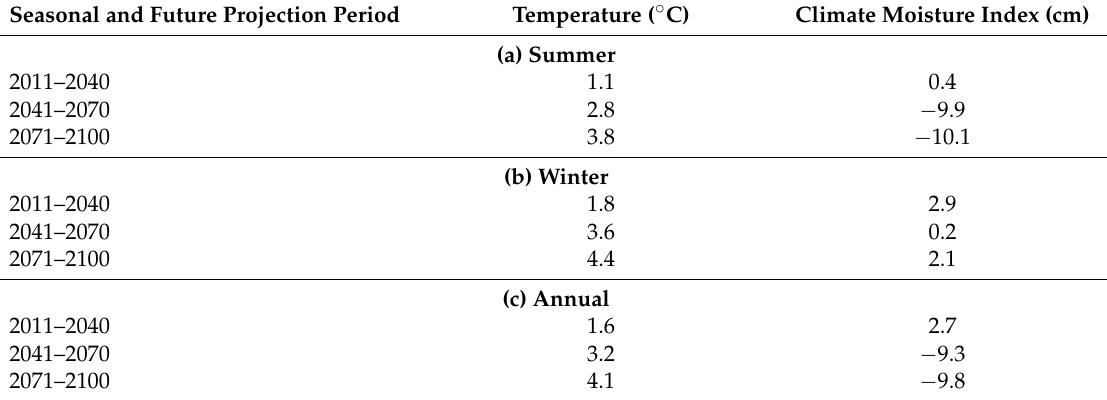
Table 4. Forecasted characteristics in climate variables derived from a general circulation model (GCM: CCCma, CGCM3, IPCC A1B).